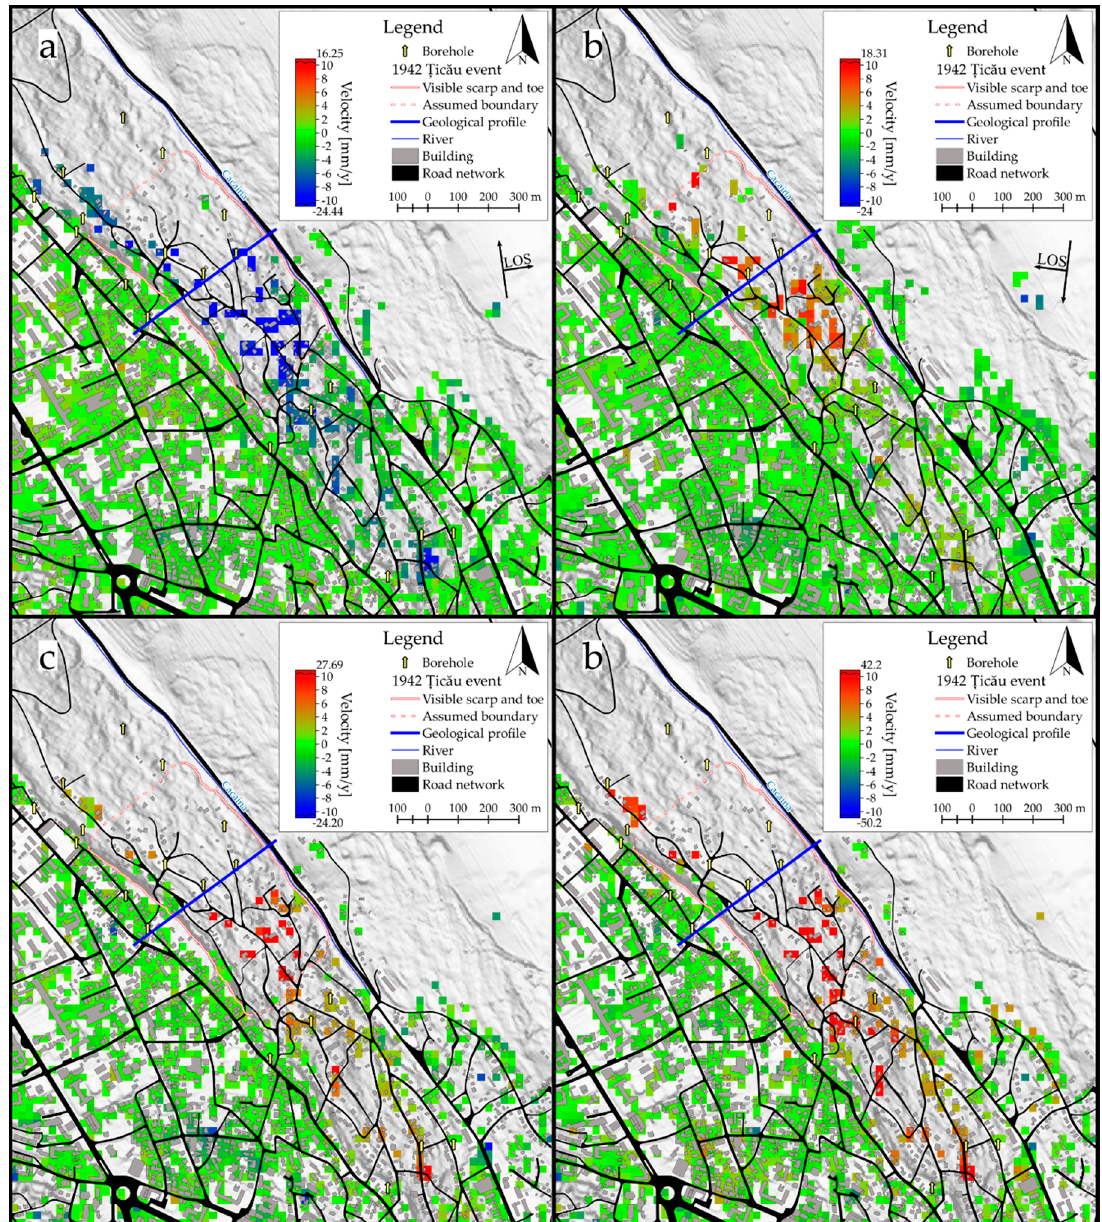
Figure 6. Velocity maps derived by processing the SAR data stacks: ( a , b ) Sentinel-1 ascending orbit, ( c , d ) Sentinel-1 de- scending orbit, and ( e , f ) ENVISAT ascending orbit. Images on the right are focused on the investigated Ț ic ă u landslide. (high-resolution image available at https://doi.org/10.6084/m9.figshare.14915292.v1).